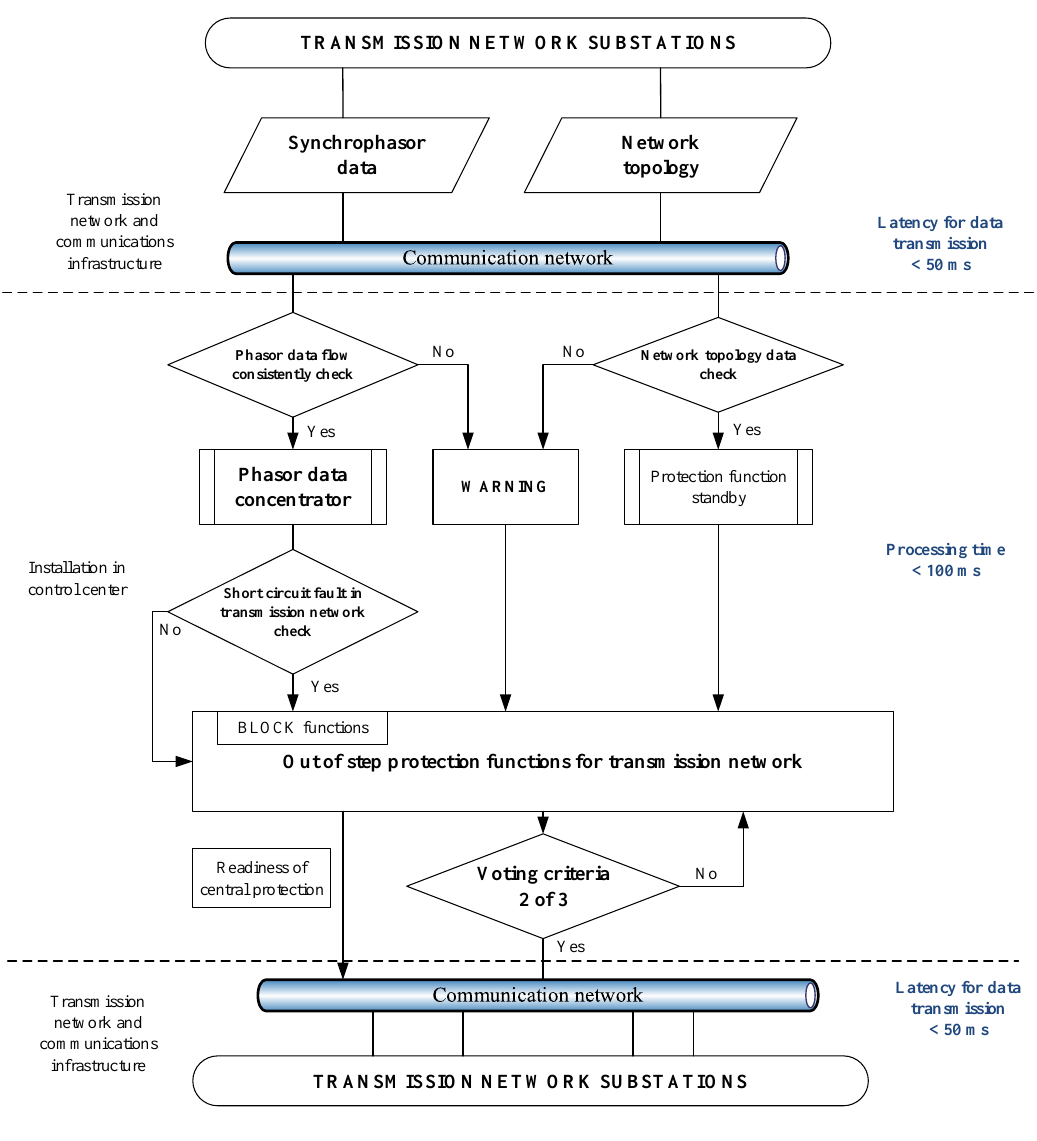
Figure 2. Flow chart design for issuing tripping command for out-of-step protection in WAMPAC system to circuit breaker in transmission network substations.